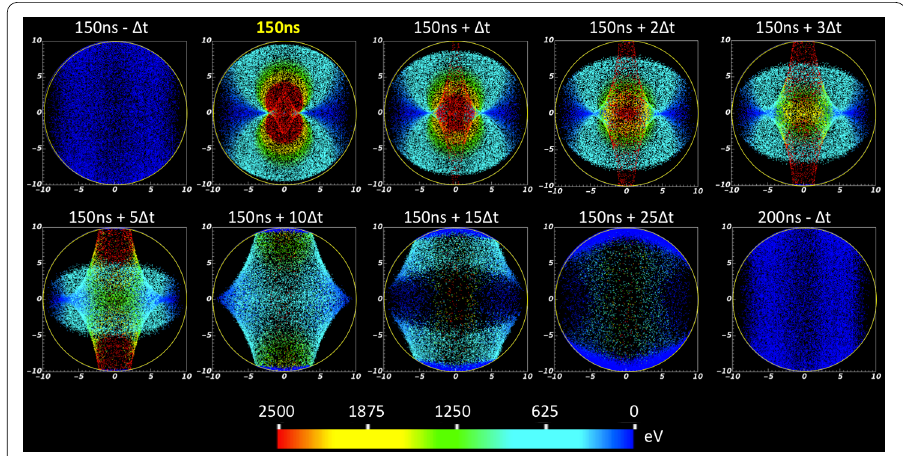
Figure 3 Kinetic energy distributions of electrons inside the wiggler magnet chamber at particular time steps between two bunch arrivals as indicated (with (cid:10) t = 62.5 ps) for FCC-ee DR